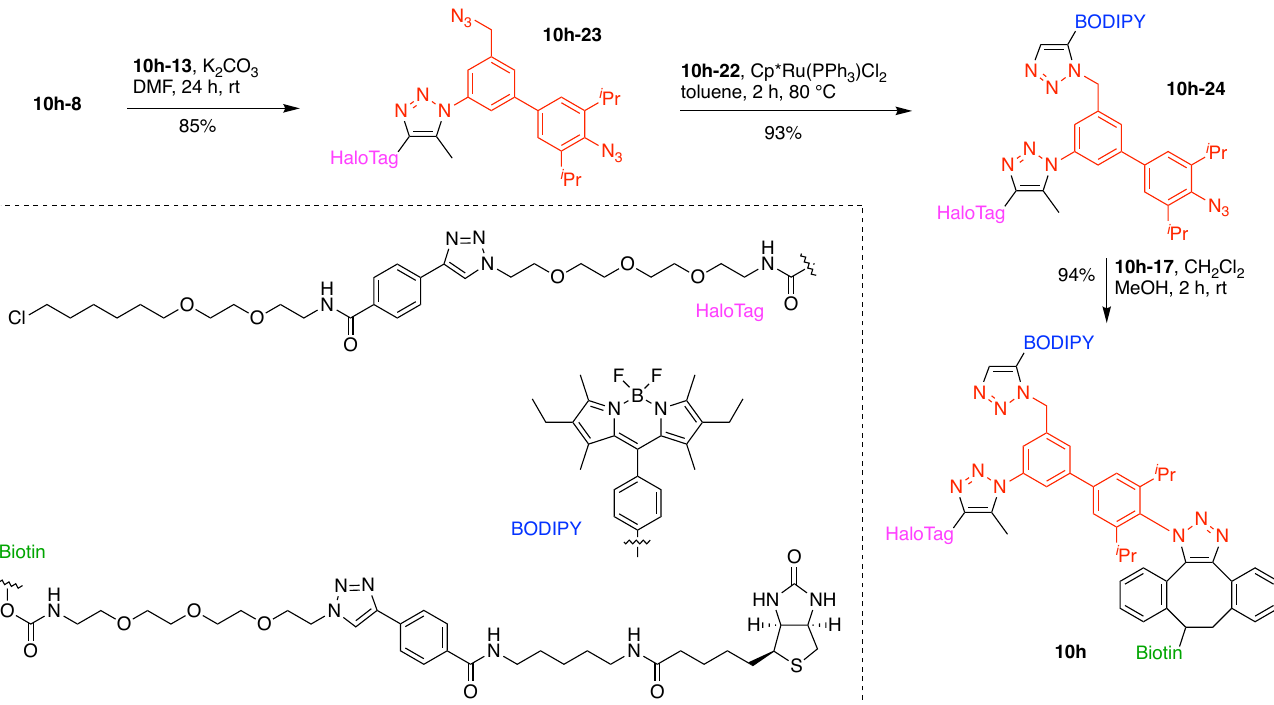
Figure 47. Sequential click chemistry with the triazido hub.